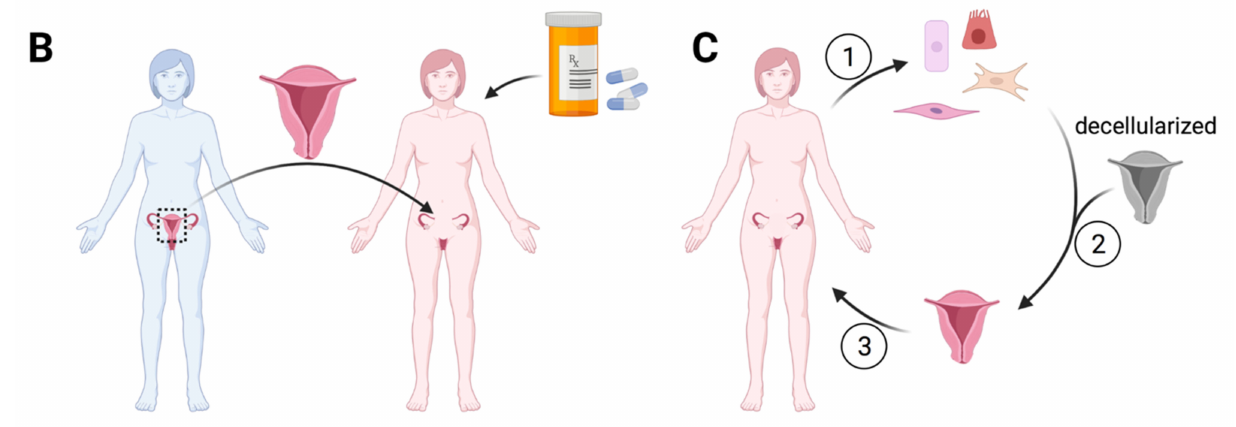
Figure 3. Prospective treatments for uterine factor infertility: ( A ) Histoanatomy of the uterus. The highly vascularized endometrium is covered by a columnar epithelium atop a stroma containing many glands and lies above the muscular myometrium. ( B ) Uterine transplant (UTx) is emerging as a potential treatment for uterine factor infertility. A live or cadaveric donor (blue) uterus is trans- planted to the patient (pink) who takes antirejection drugs until childbearing is finished. ( C ) Tissue engineering could restore uterine function. Murine models have restored uterine function by seeding a decellularized uterus with autologous uterine cells. Numbers indicate procedure order Figure created with